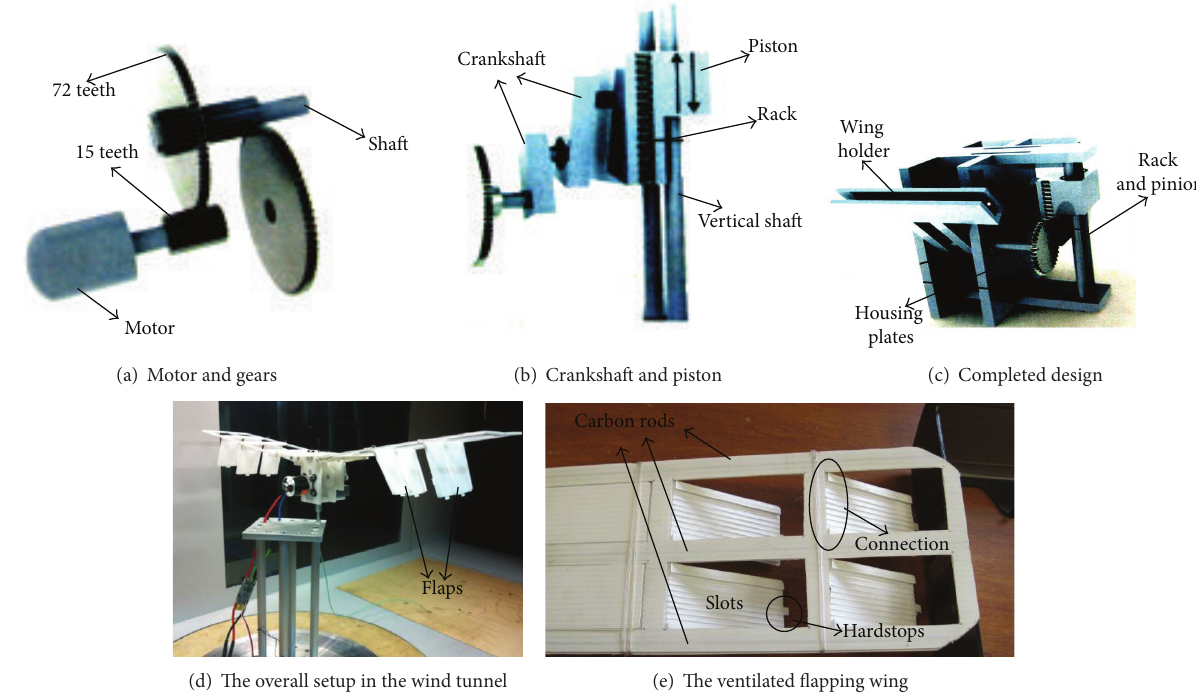
Figure 2: Experimental setup and ventilated flapping